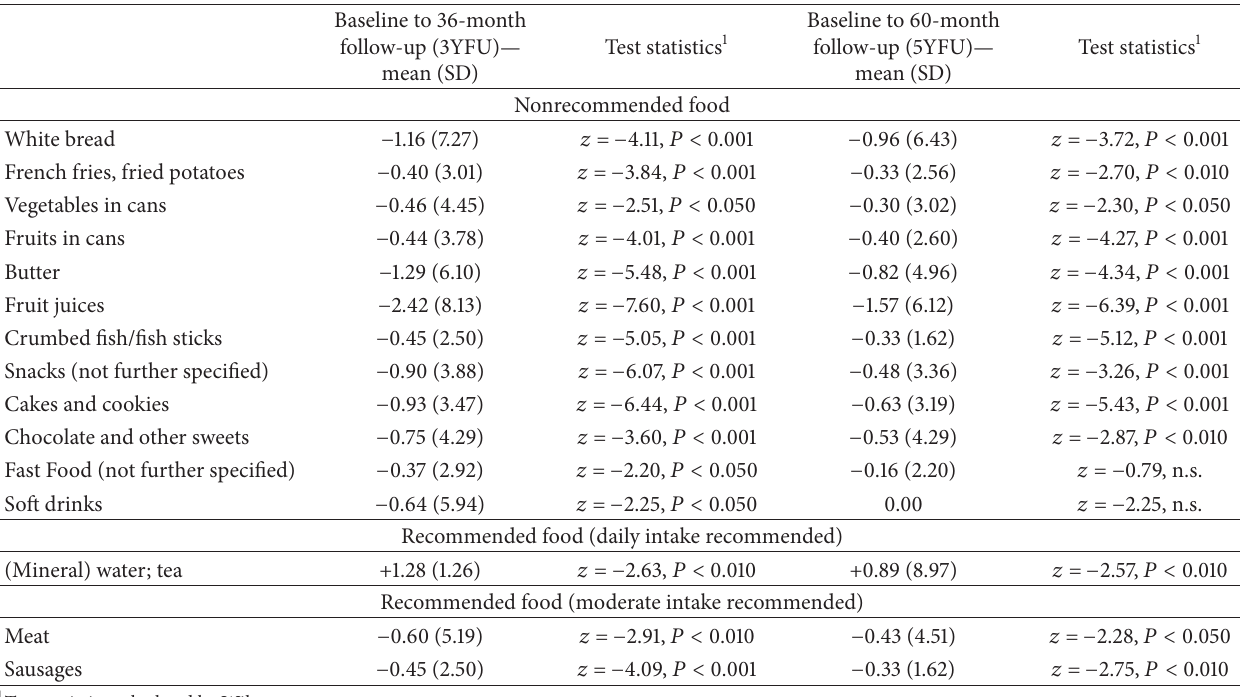
Table 5: Changes in average number of portions or servings consumed per week (mean (SD)) from baseline to 3- and 5-year follow-up. Foods and beverages are grouped into recommended and non-recommended food and beverages based on the recommendations of the Research Institute of Child Nutrition (FKE) Dortmund [56, 57], ( 𝑁 = 604 ; baseline observation carried